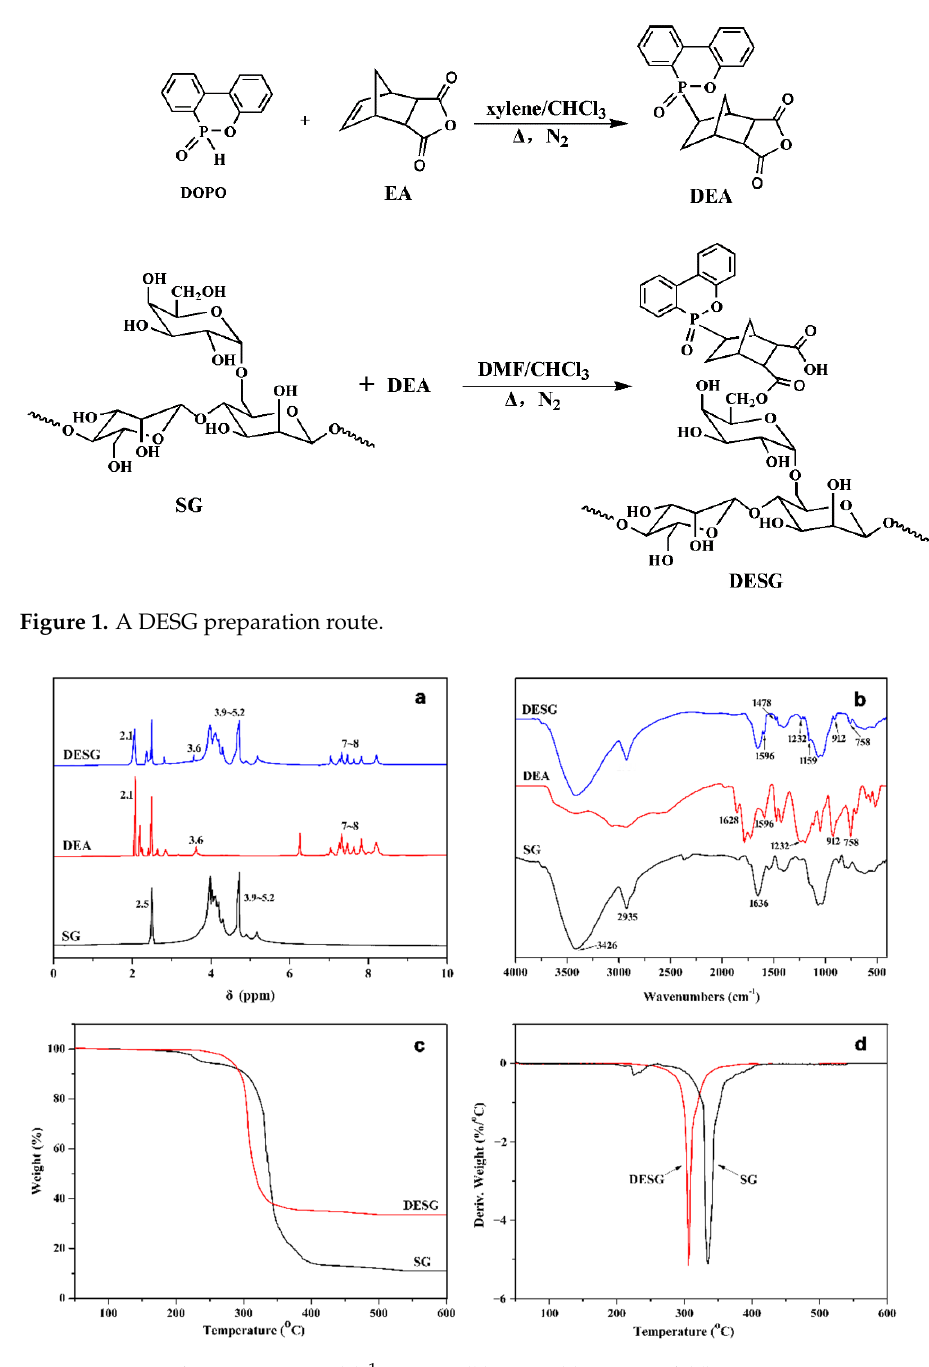
Figure 2. SG and DESG curves: ( a ) 1 HNMR, ( b ) FTIR, ( c ) TGA and ( d ) DTG.